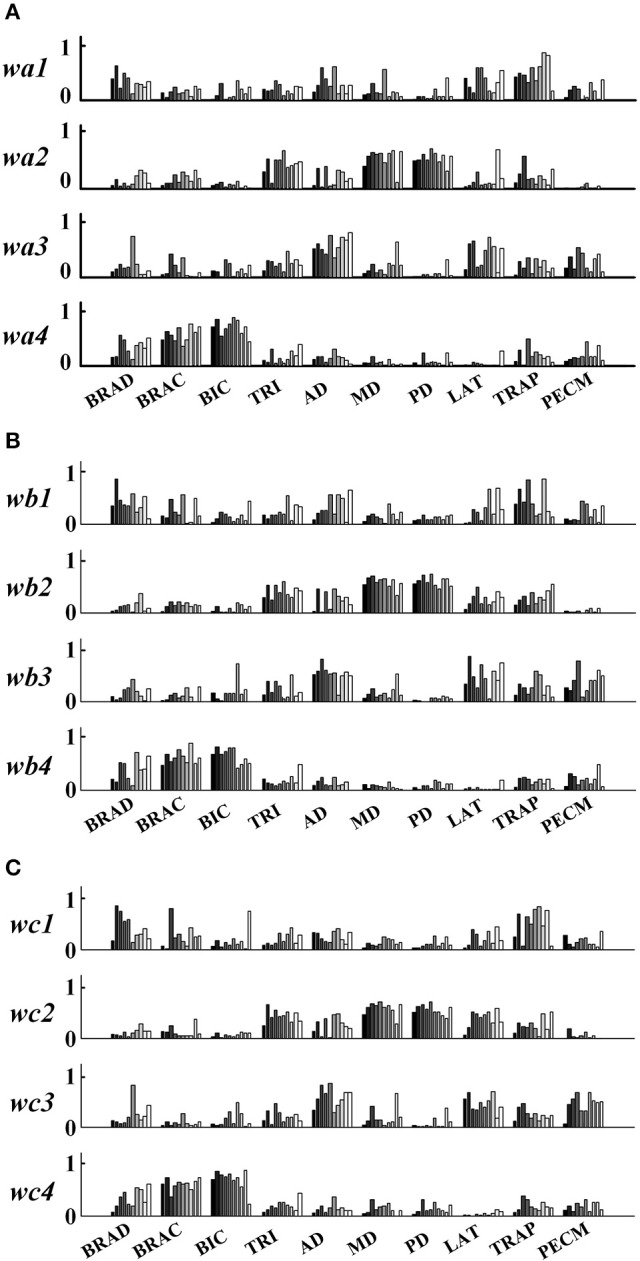
Muscle synergies extracted from 10 healthy children. (A) Task 1, (B) Task 2, and (C) Task 3. Ten groups in the horizontal axis corresponds to 10 muscles, and each group contains data from 10 subjects (left to right: TD 1~TD 10).